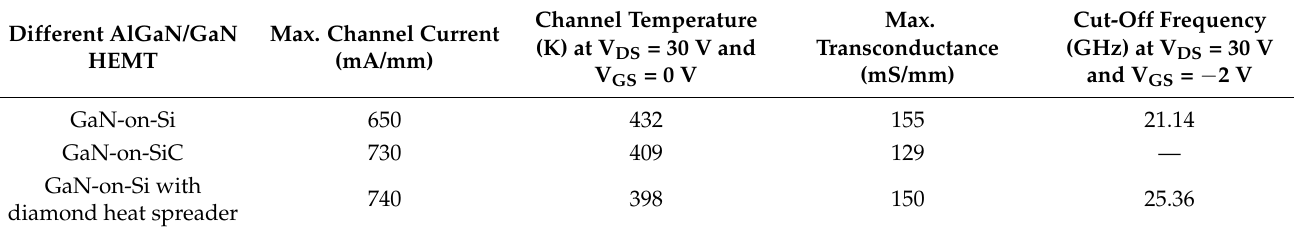
Figure 3. Simulated lattice temperature profile in AlGaN/GaN HEMT at V DS = 30 V and V GS = 0 V. ( a ) GaN-on-Si. ( b ) GaN-on-SiC. ( c ) GaN-on-Si with diamond heat spreader. Gate edge represents the two gate fingers [36]. Table 2. Simulated electrical behavior of different AlGaN/GaN HEMTs